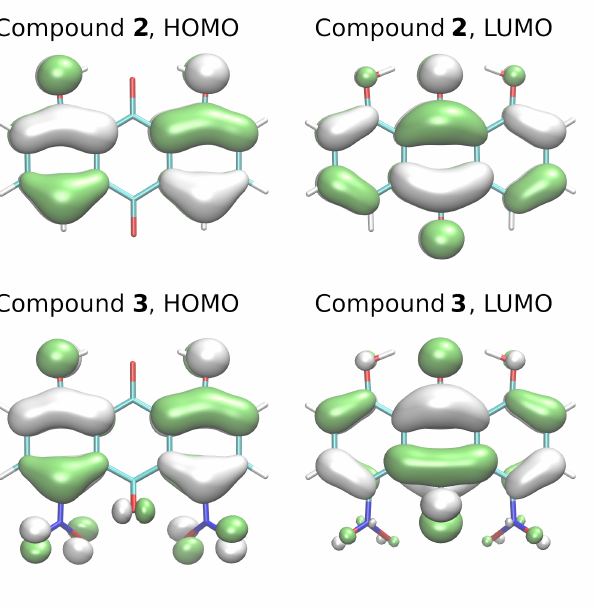
Figure 8. HOMO and LUMO orbitals for the compounds 2 and 3 computed at the ω B97XD/6- 311+G(d,p)